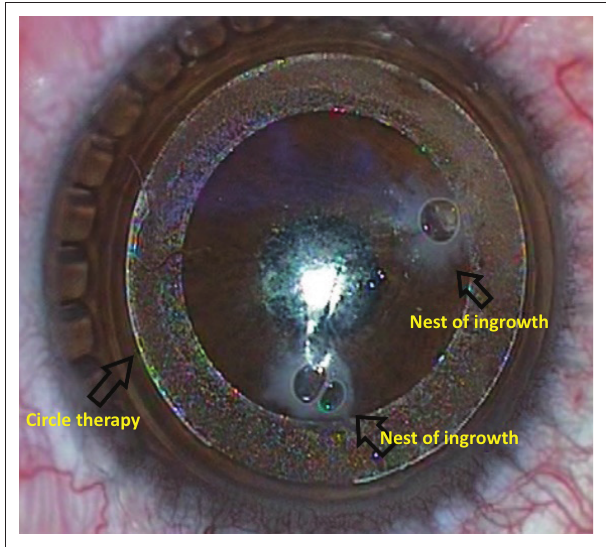
FIGURE 6: Two nests of epithelial ingrowth during circle therapy.